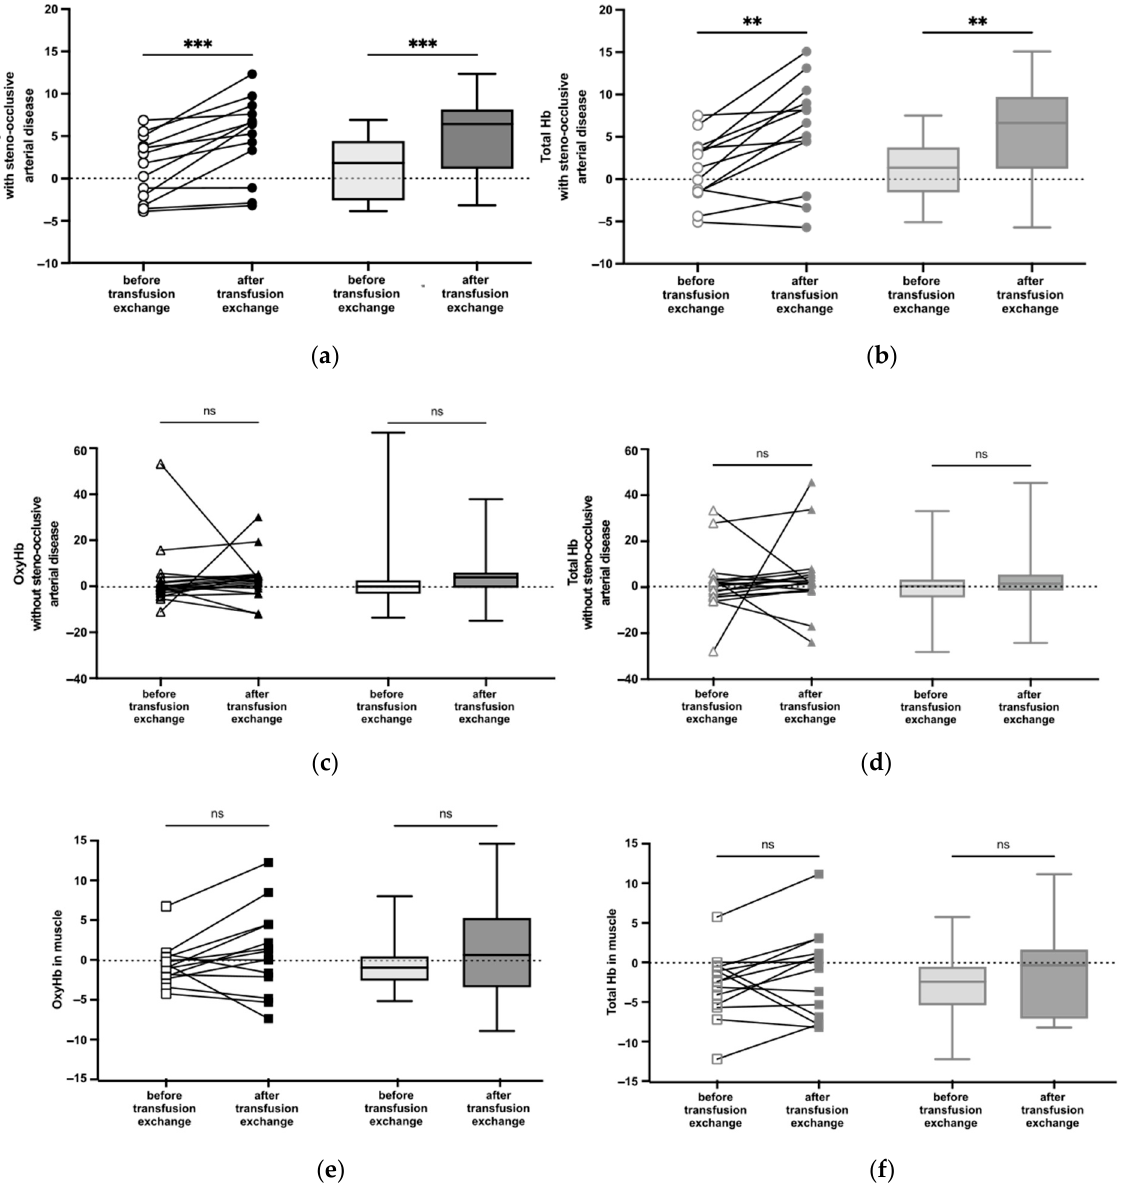
Figure 1. NIRS measurement of relative amounts of OxyHb and Total Hb before and after BET. Box whisker plots show range, interquartile percentages, and median values for OxyHb and Total Hb. ( a ) OxyHb in cerebral hemispheres with steno-occlusive arterial disease ( n = 13). ***, p < 0.001 using the Wilcoxon test. ( b ) Total Hb in cerebral hemispheres with steno-occlusive arterial disease ( n = 13). **, p < 0.01 using the Wilcoxon test. ( c ) OxyHb in cerebral hemispheres without steno-occlusive arterial disease ( n = 19). ns, not significant using the Wilcoxon test. ( d ) Total Hb in cerebral hemispheres without steno-occlusive arterial disease ( n = 18). ns using the Wilcoxon test. ( e ) OxyHb in muscle ( n = 14). ns using the Wilcoxon test. ( f ) Total Hb in muscle ( n = 14). ns using the Wilcoxon test.